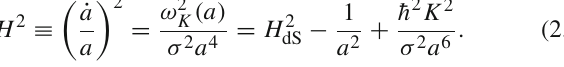
/ M 2 , which relates the scale of inflation dS P